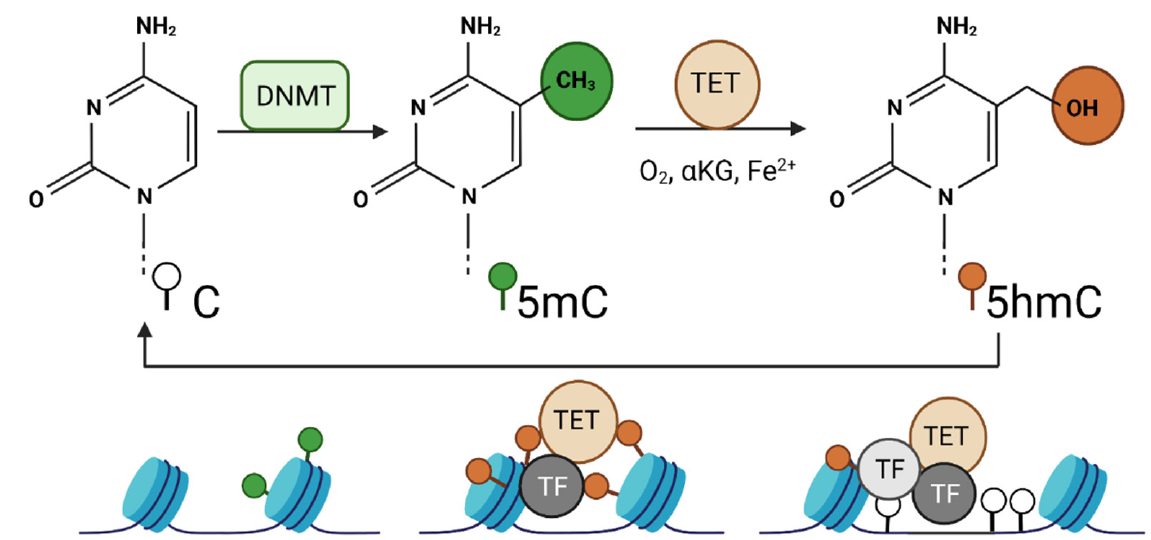
Figure 1. TET-mediated DNA modification and gene expression. Cytosine ( C ) residue is modified by DNMT enzymes into 5-methylcytosine (5mC) which is then oxidized into 5-hydroxymethylcytosine (5hmC) by the enzymatic activity of TETs. TET enzymes depend on oxygen, alpha-ketoglutarate ( α KG), and iron (Fe 2+ ) for the oxidation reaction. TET enzymes are recruited to the DNA on the nucleosome by transcription factors (TFs). TET enzymes oxidize 5mC to 5hmC and in successive oxidation steps cytosine is unmodified and demethylated. This allows binding of other transcription factors and remodeling of the nucleosome.